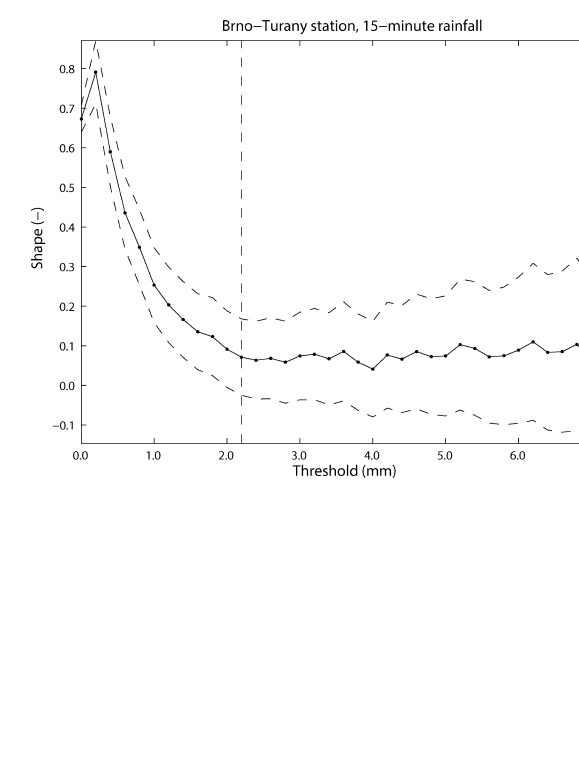
Fig. 2. Selection of the threshold u for the aggregation level of 15 min at the Brno-Tu ř any station. The estimated parameters are denoted by solid lines and the 95% confidence intervals are traced with dashed lines. Vertical lines denote the optimal threshold u = 2.2 .